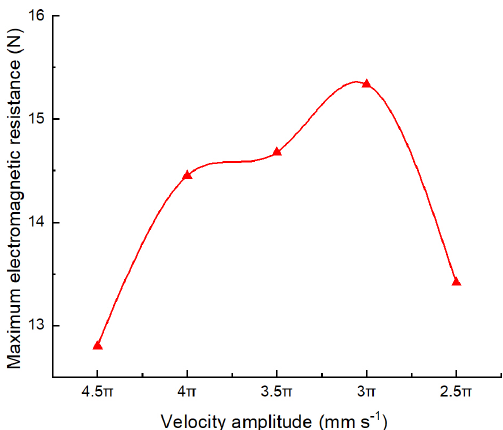
Figure 14. Influence of different velocity amplitudes on the maxi- mum value of electromagnetic